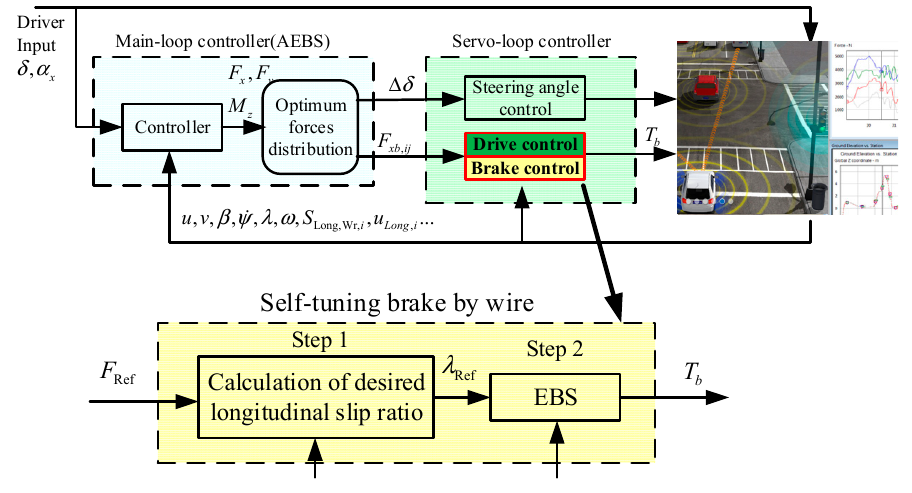
Figure 1. Hierarchical control structure of AEBS (Advanced Emergency Braking System).